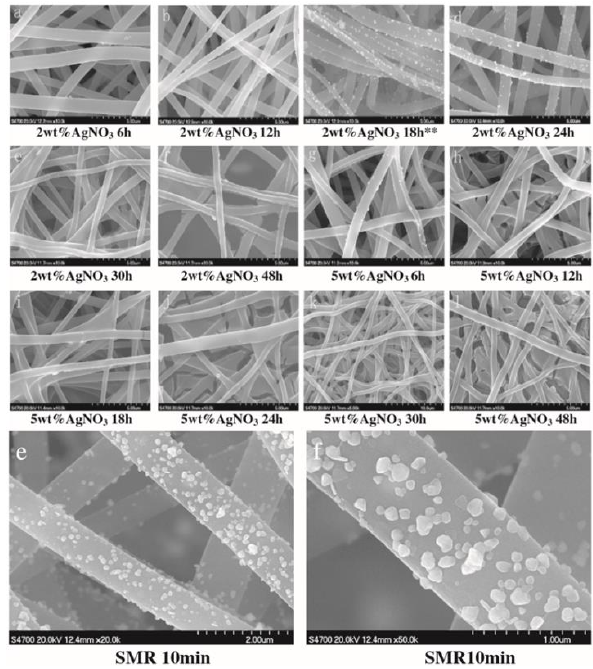
Figure 7. SEM images of pretreating PAN (polyacrylonitrile) nanofibers in Ag NO 3 solution at different soaking times, different concentrations, and different reduction reaction time. Reprinted from [108], Copyright 2015, with permission from Elsevier.